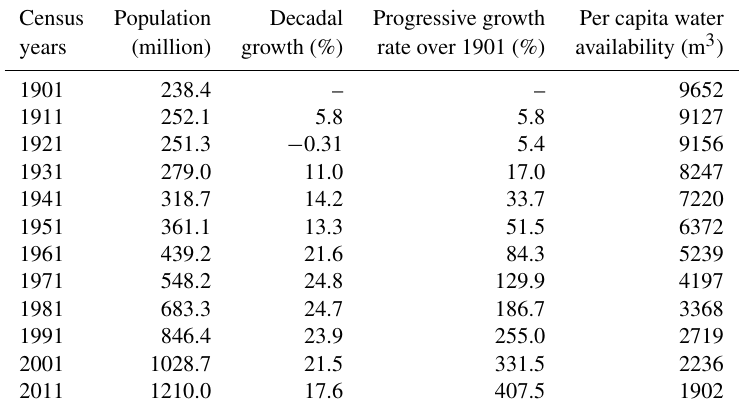
Table 2. Population and water availability trends in India (M.I&B, 2012).